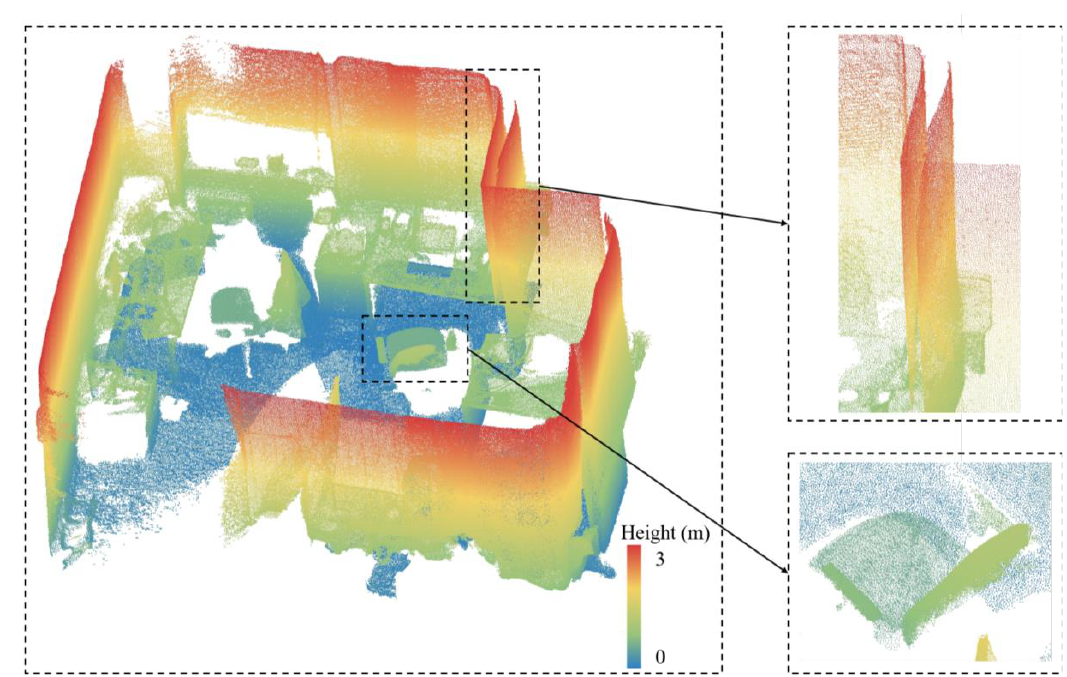
Figure 12. Office dataset with height as the color bar.